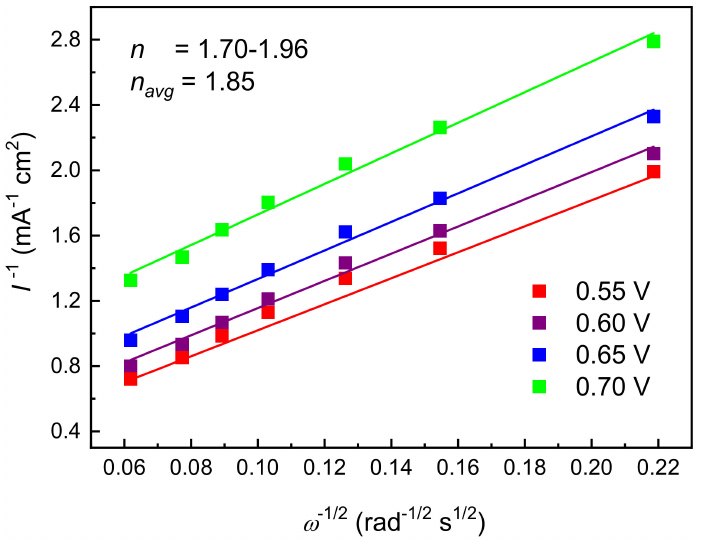
Figure 3. Koutecky–Levich plots of the Ni(dto)-DH/C electrode in the oxygen-saturated 1 M KOH solution at different working electrode